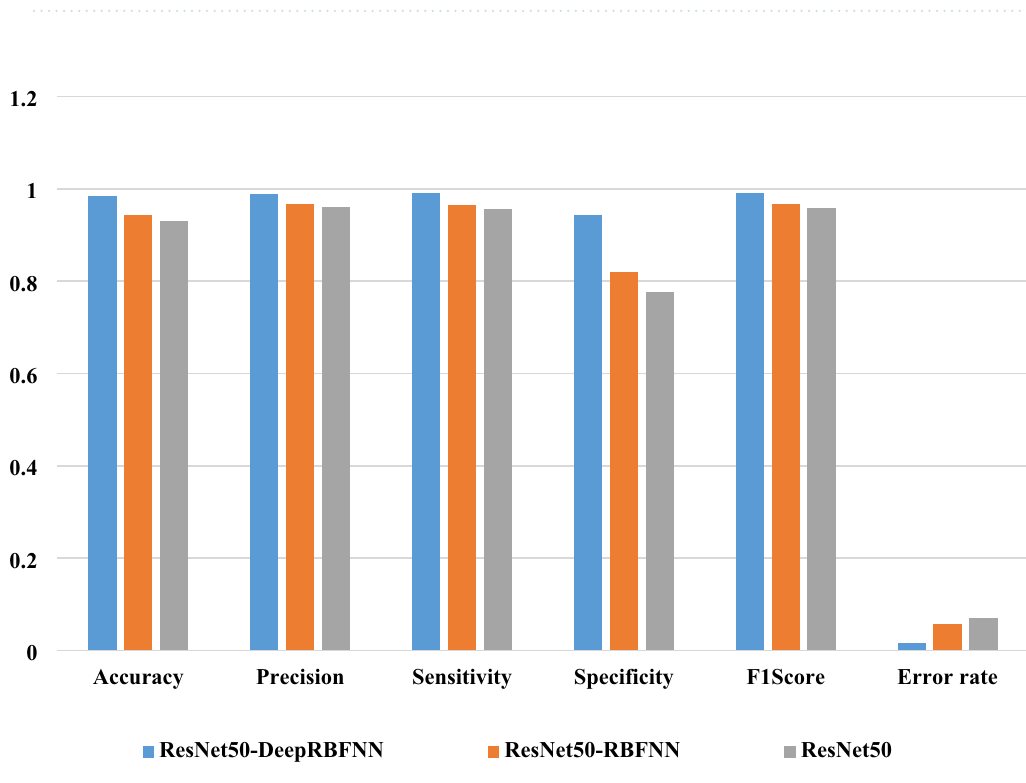
Table 6. Error variations based on number of epochs evolved.